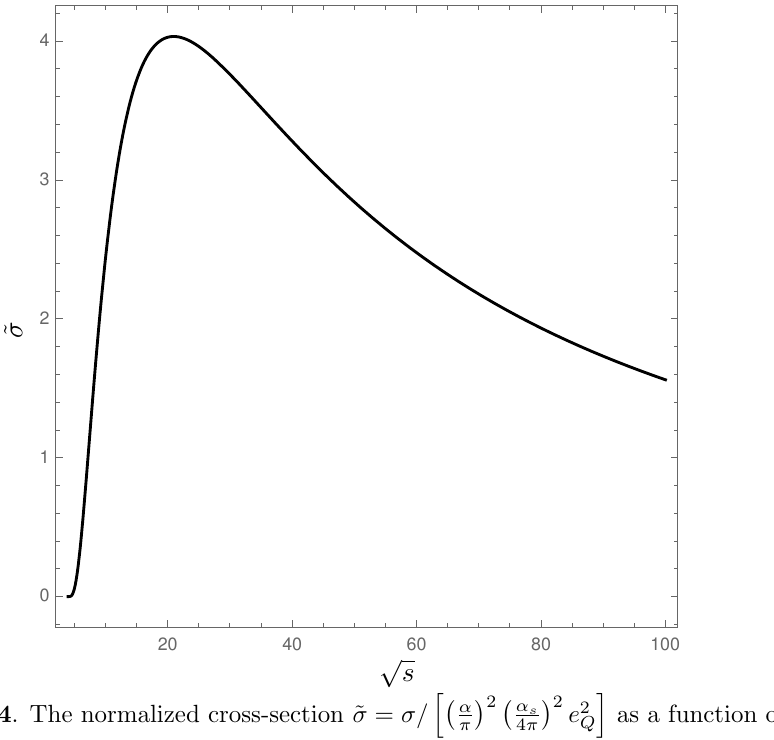
Figure 4 . The normalized cross-section ~ (cid:27) = (cid:27)= Apart from the 3 (cid:2) 3 upper left block, the matrix M